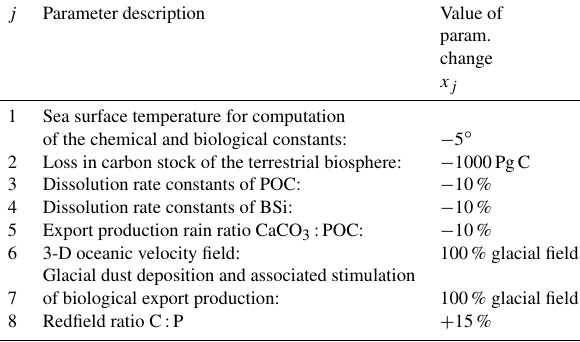
Table 2. Parameter changes x j , j = 1, ..., n ; n = 8 as imposed in the sensitivity experiments with the full 3-D biogeochemical model relative to the control run parameter choice. The x j are the maxi- mum amplitude of change for the respective strongest excursion of the observed δ D curve at the LGM.